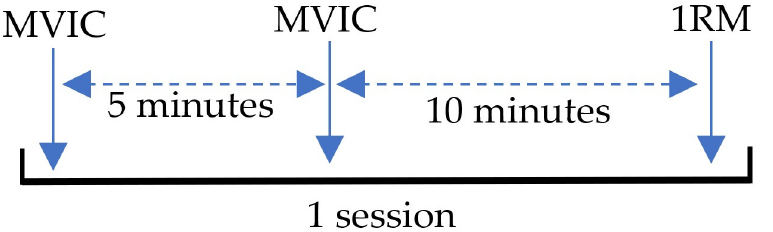
Figure 1. Evaluation design. 1RM—one-repetition maximum; MVIC—maximum voluntary isometric contraction.